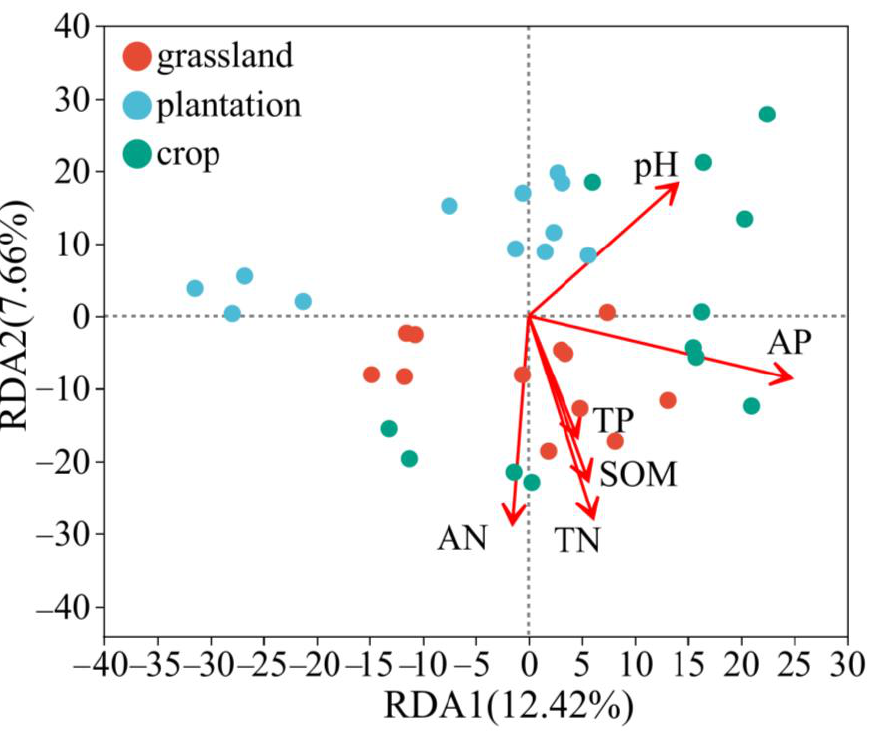
Figure 9. RDA analysis of bacterial community at OUT level and soil physicochemical factors in three karst land-use types.